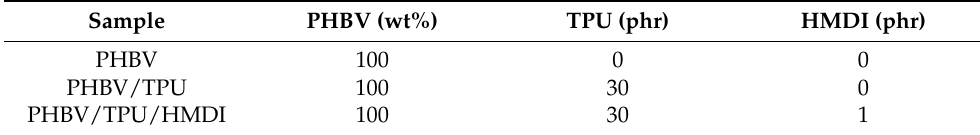
Table 1. The nomenclature and composition of the